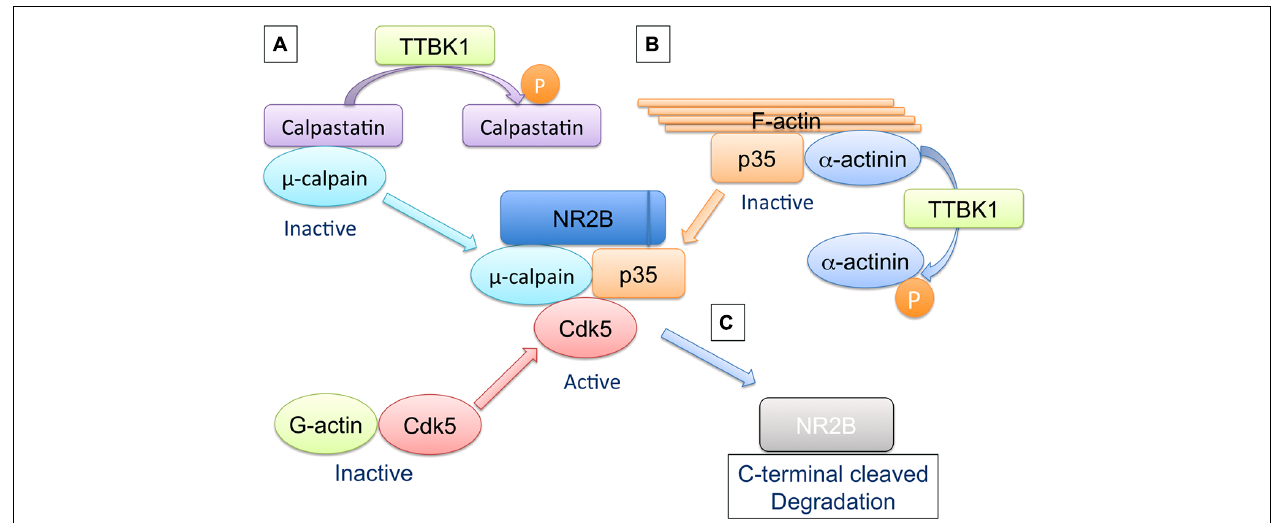
FIGURE 3 | Hypothetical regulation of μ -calpain activation, Cdk5/p35 complex formation, and NR2B degradation by TTBK1. (A) Inactive μ -calpain forms a stable complex with calpastatin, and TTBK1 dissociates the complex via direct or indirect phosphorylation of either μ -calpain or calpastatin, leading to the activation of μ -calpain. (B) FAA (F-actin and α -actinin complex) forms a stable complex with p35. G-actin is associated with Cdk5. These two statuses prevent the Cdk5/p35 complex formation